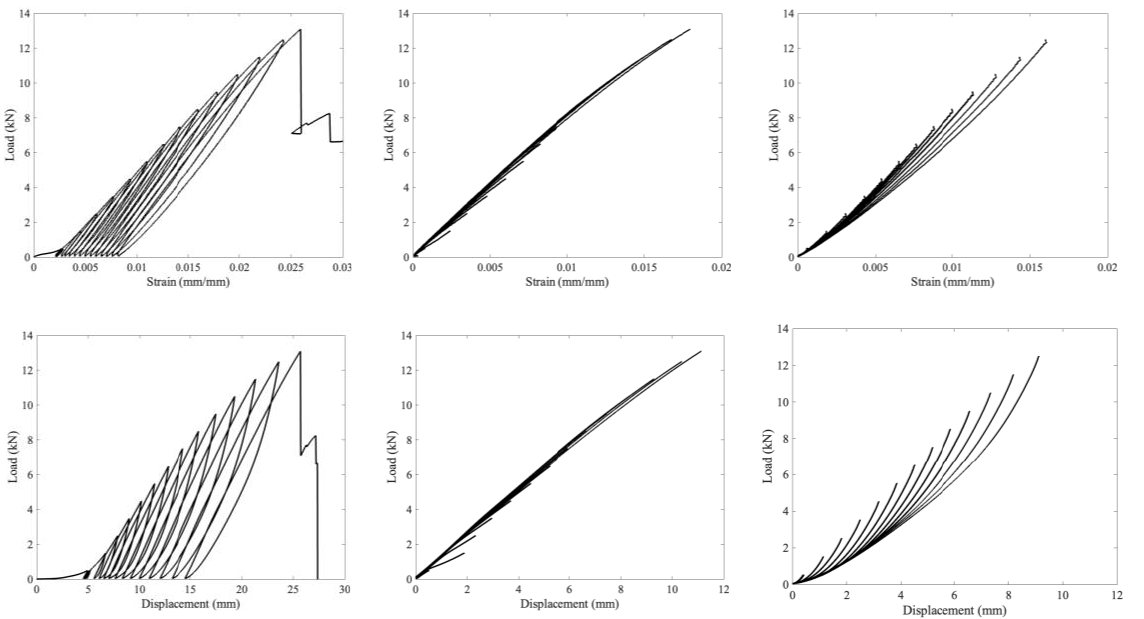
Figure 9. Unaged cyclic-tested specimen with load vs. strain on top and load vs. displacement on bottom. Left plots the whole loading, middle the superimposed loading portions of the curves, and right the superimposed unloading portions of the curves. The curves in the middle and right columns were shifted to start at 0 mm displacement.